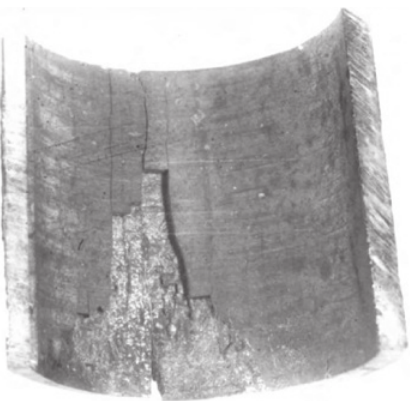
Fig. 1: Photograph of the failed pendent reheater tube.